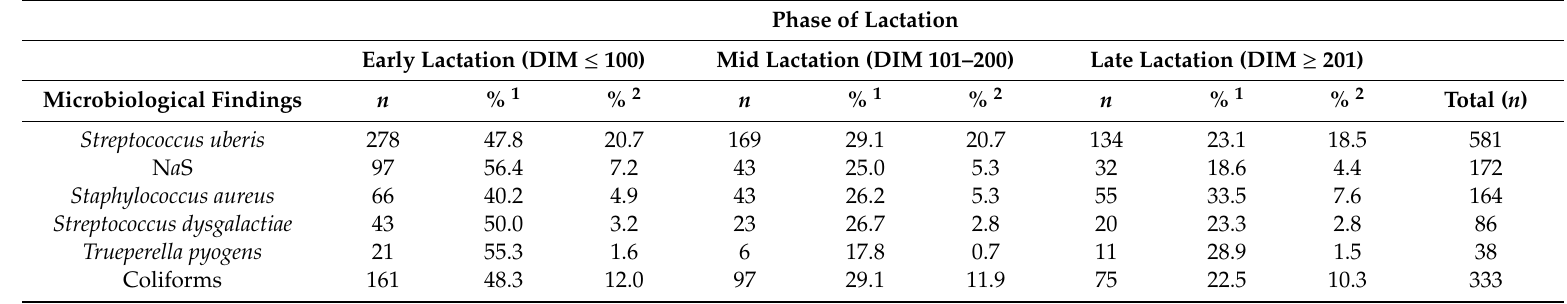
Table 3. Microbiological results based on conventional diagnostic methods ( n = 2883 mastitic udder milk samples) and their distribution by phase of lactation. Phase of